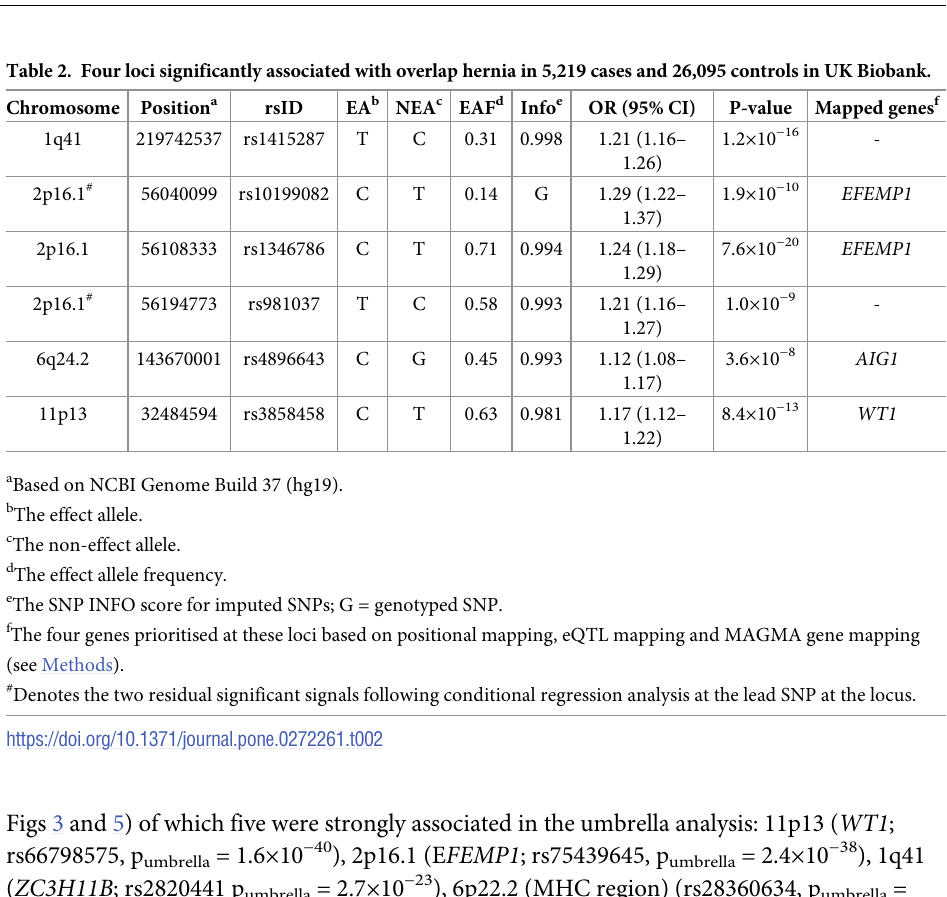
Figs 3 and 5) of which five were strongly associated in the umbrella analysis: 11p13 ( WT1 ;